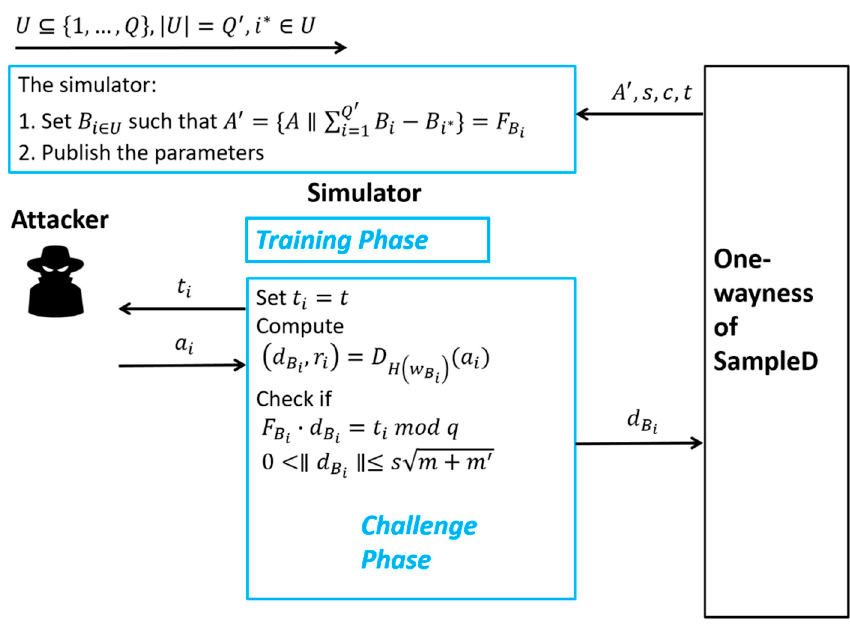
Figure A5. The authenticity of the user.